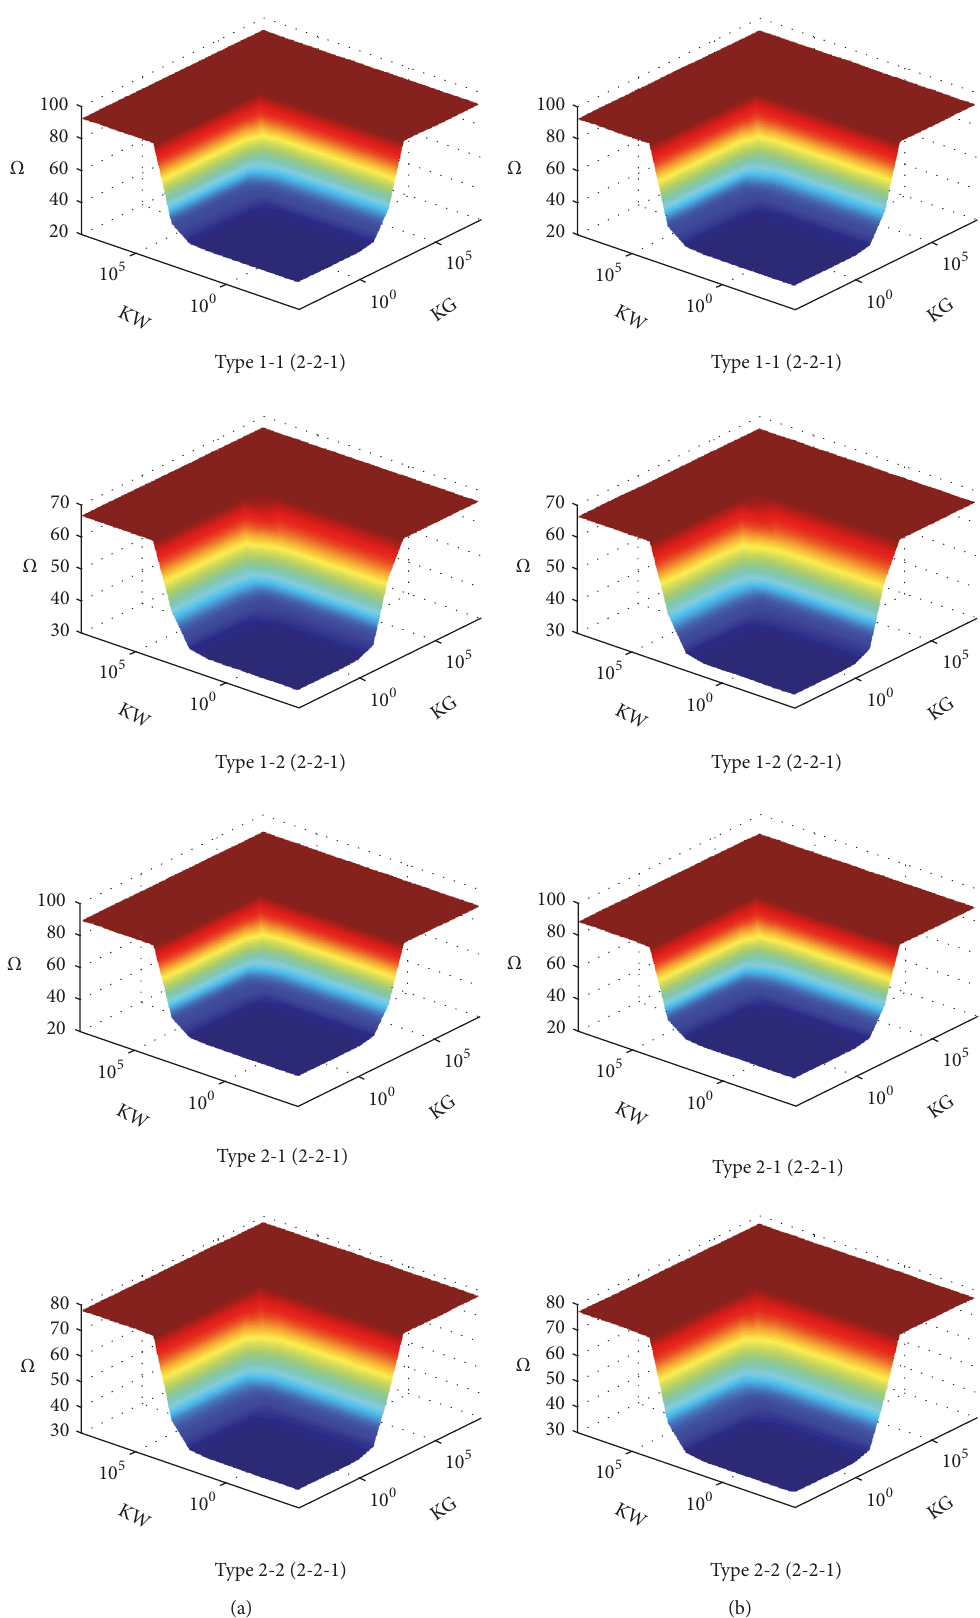
Figure 16: Variation of the frequency parameters Ω versus the elastic foundation coefficients for circular sector plates with different boundary conditions: (a) CCC; (b) E 2 E 2 E 2